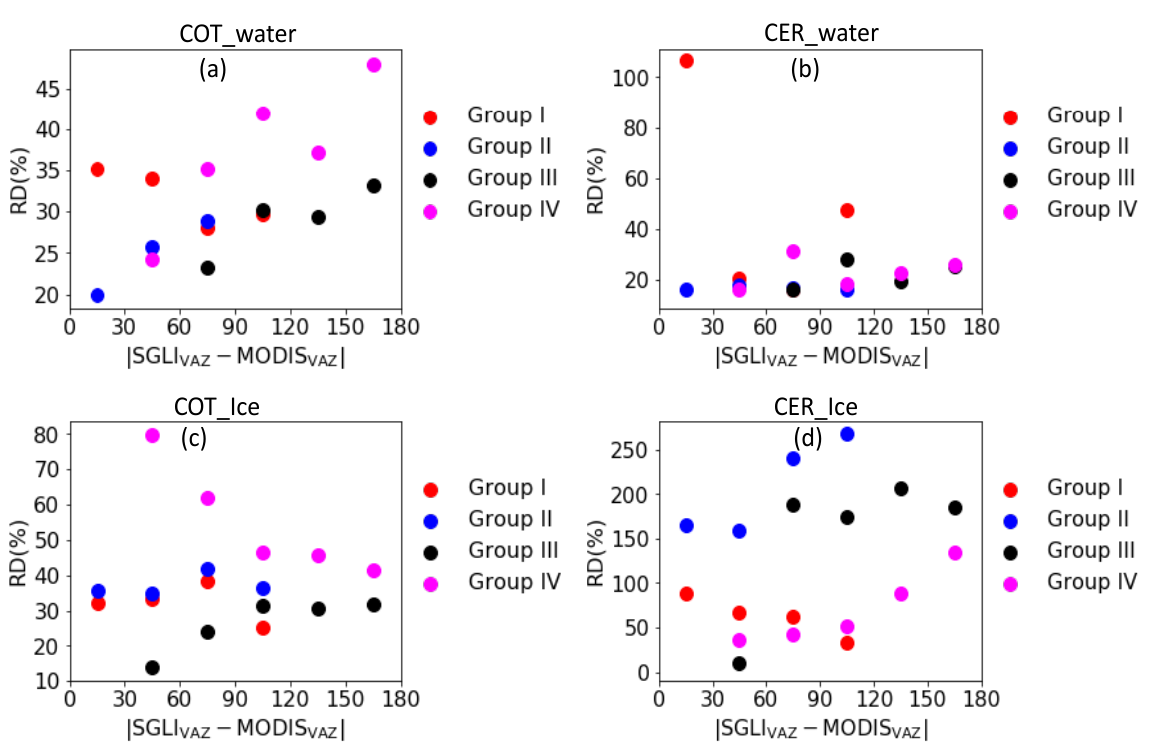
Figure 8. RD values as functions of absolute VAZ difference between SGLI and MODIS sensors for ( a ) COT and ( b ) CER of water clouds and ( c ) COT and ( d ) CER of ice clouds.